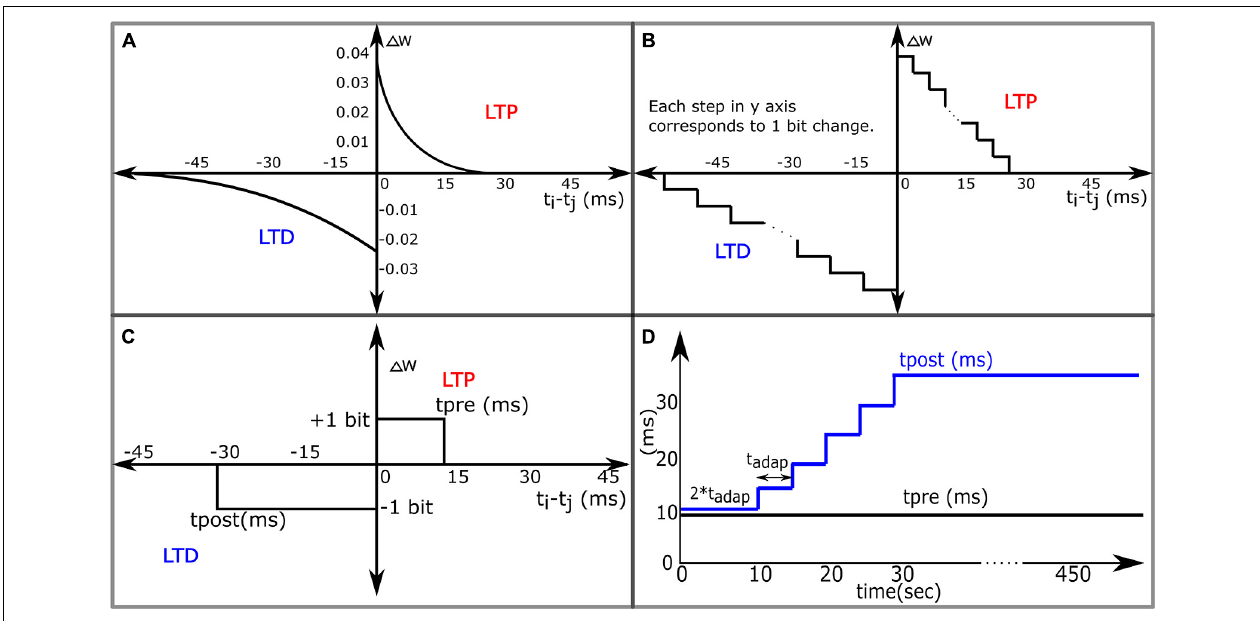
FIGURE 1 | Variants of the STDP learning rules. (A) The STDP learning rule. (B) The STDP Learning Rule for Neuromorphic Systems with DACs and digital memories configuring synaptic weights. (C) 1-bit rectangular STDP. (D) Adaptive STDP: the value of tpost in 1-bit rectangular STDP is varied in steps over